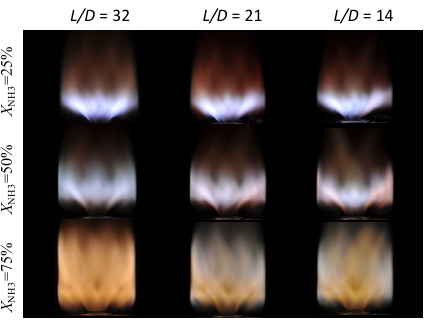
Figure 4. Time ‐ averaged broadband images of methane ‐ ammonia flames for different mixing length Figure 4. Time-averaged broadband images of methane-ammonia flames for different mixing length ratios and ammonia fractions and at a fixed equivalence ratio of 1.0. ratios and ammonia fractions and at a fixed equivalence ratio of